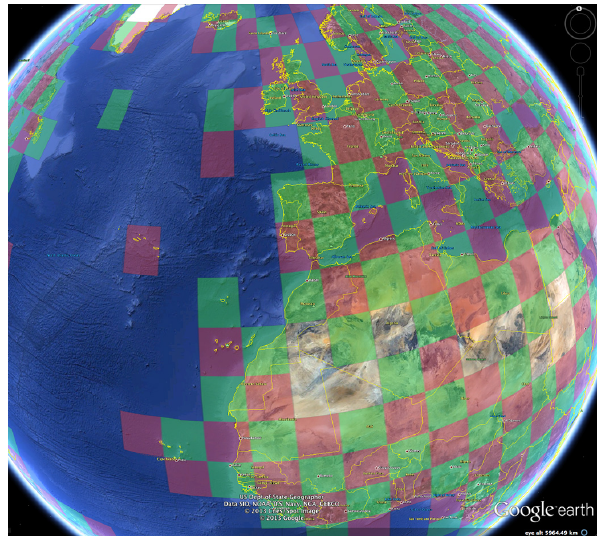
Figure 3. Image from Google Earth showing a box that appears after clicking on one of the highlighted grid boxes. The box shows the annual-mean temperature anomaly time series as bars (blue for values below the 1961–1990 reference period mean, red for values above) with a black line for the 20yr smoothed variations. The box also shows the location of the centre of the grid box and provides links to a larger image of the annual time series, to an image of the seasonal-mean temperature anomaly time series, to a text file containing the monthly, seasonal and annual temperature anomaly values for this grid box, and a link to load into Google Earth a KML file for the CRUTEM4 weather stations that lie within this grid